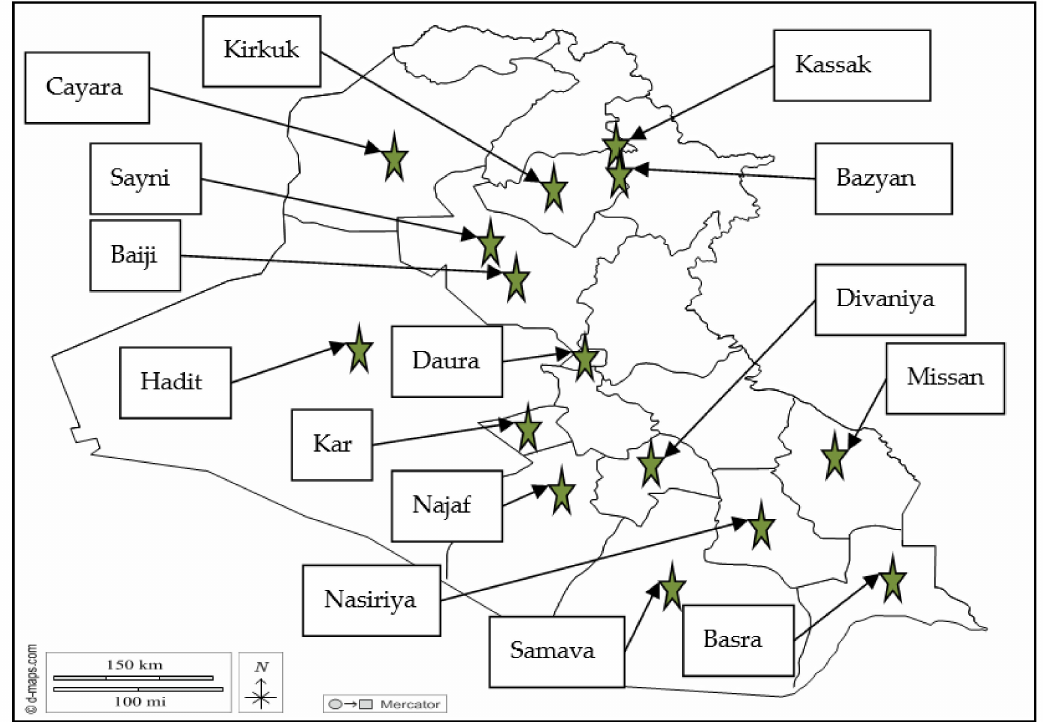
Figure 1. Location of oil refineries in